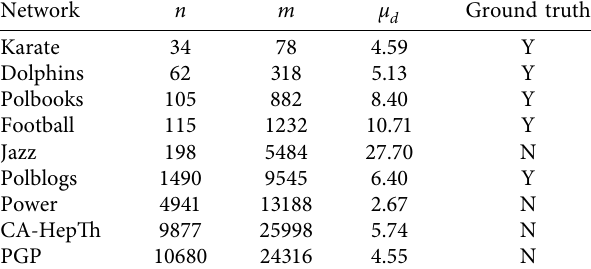
Figure 5: Function of α � | sin z | oscillates between 0 and 1, causing the mutation probability distribution to change. δ defnes the length of q q each step ( δ � 0 . 1 ) . Table 2: Te summarized information of the real-world datasets which we use to compare the performance of the proposed method; n indicates the number of nodes of the graph, m denotes the number of edges of the network, and μ d is the average degree of each node.